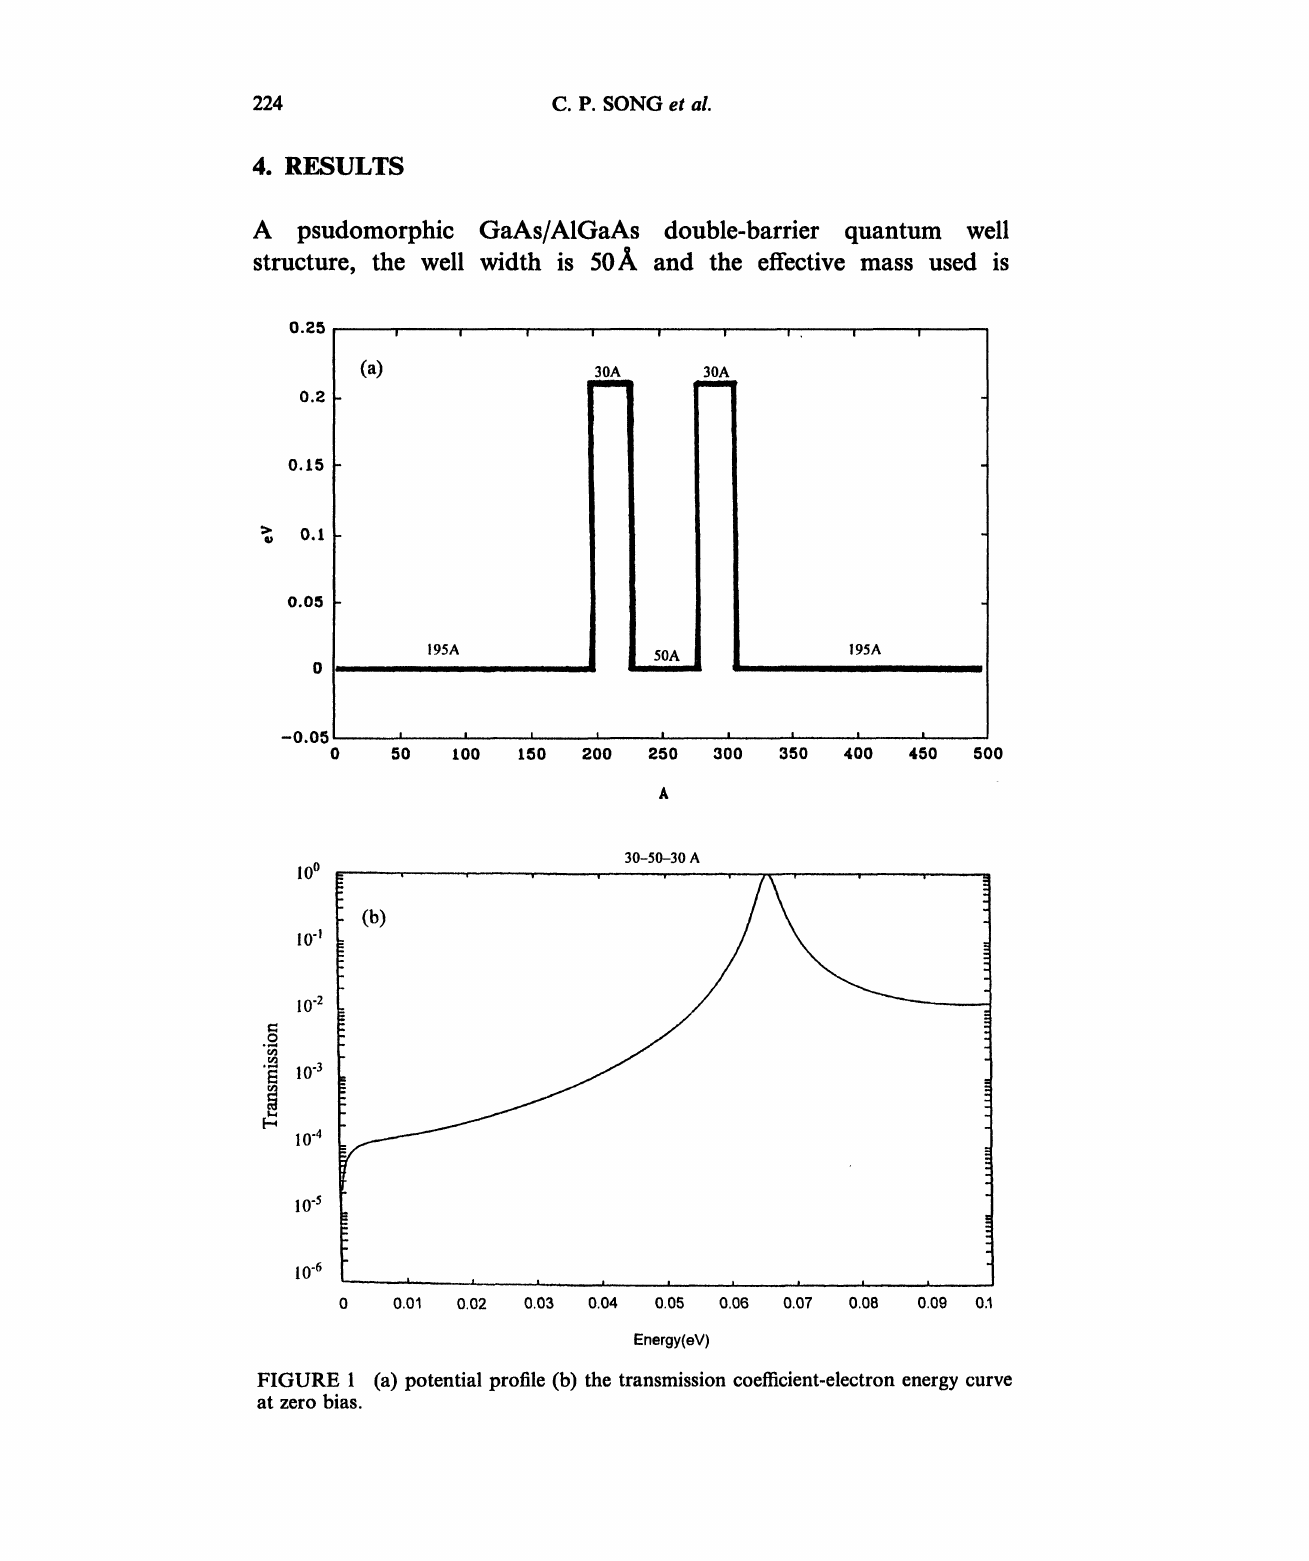
(a) potential profile (b) the transmission coefficient-electron energy curve at zero